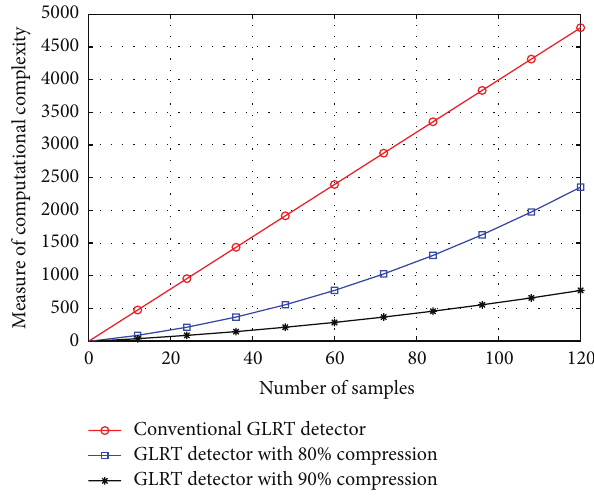
Figure 3: 𝑃 𝐷 comparison of a conventional C-GLRT detector and the proposed C-GLRT detector in the presence of clutter at 50% compression.